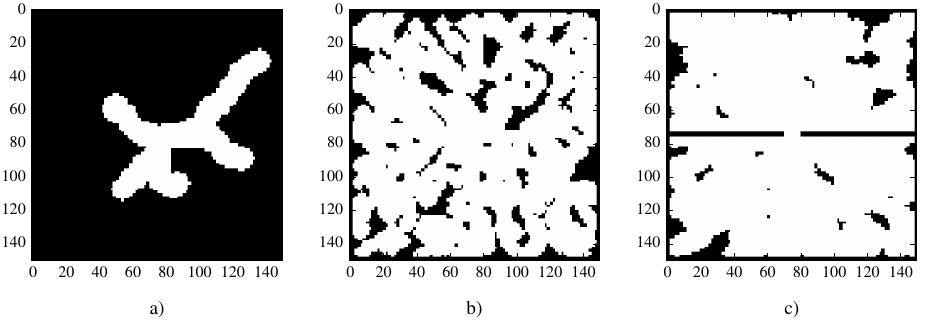
Figure 11. Example of maps types. A 15 m × 15 m area is shown. ( a ) Easy , with approximately 75 m 2 of walkable space; ( b ) hard , with approximately 200 m 2 of walkable space and with a greater entropy; ( c ) wall , the same as hard , but with a wall that divides the map into two